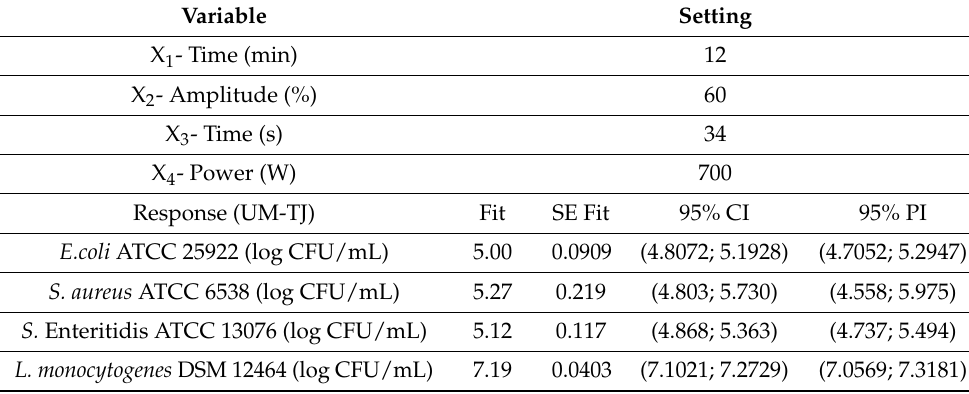
Table 4. The optimization values according to